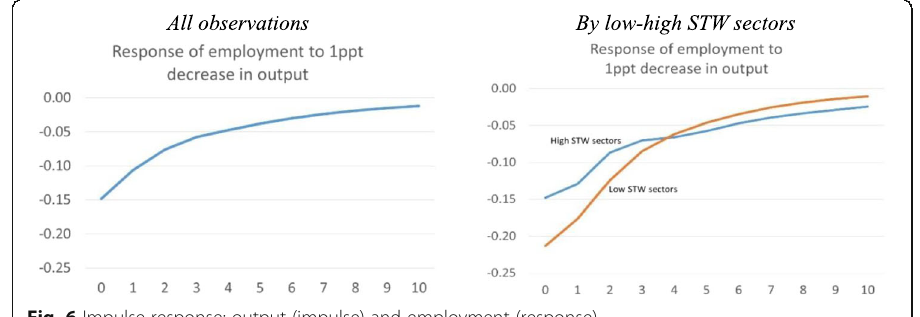
Fig. 6 Impulse response: output (impulse) and employment (response)